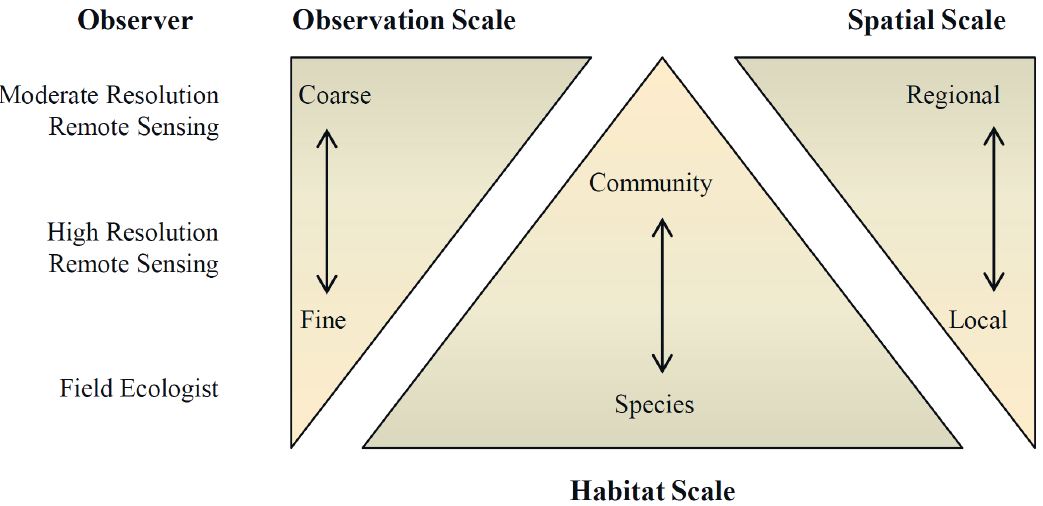
Figure 9. The Pyramids of Observation relating the different scales at which biodiversity is measured from the perspective of both remote sensing and field-based